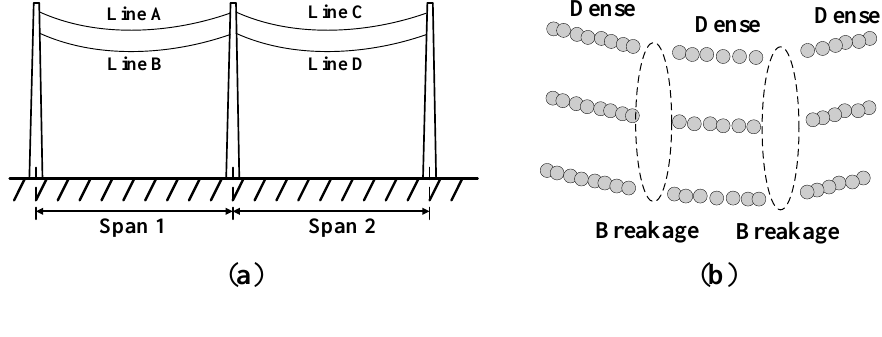
Figure 5. Clustering of power line points. ( a ) Section of a power line corridor. ( b ) Power line points in vehicle-borne LiDAR